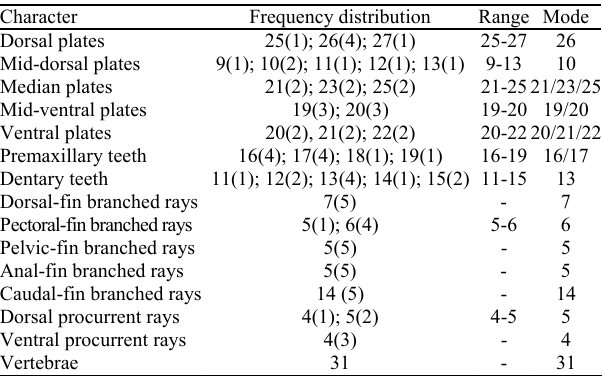
Table 4. Frequency distribution of meristics for Microlepidogaster perforatus . Plates (counted in both